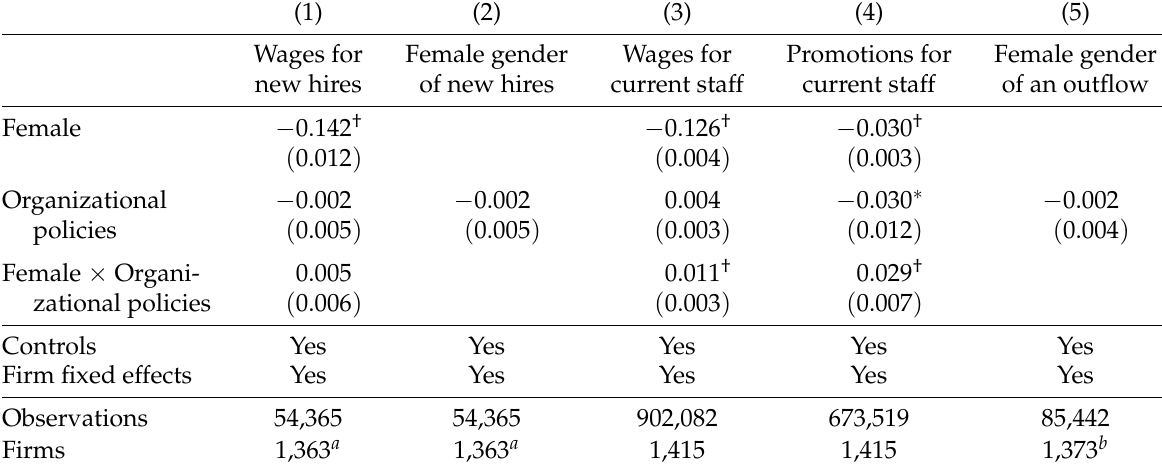
Table 5: Disentangling the effect of organizational policies on current staff and new